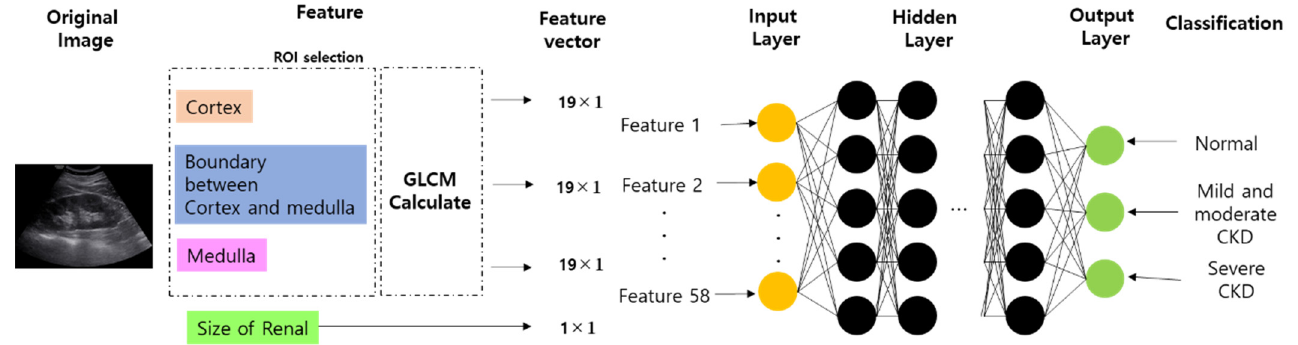
Figure 4. Output classification based on the ANN model. Table 3. Parameters of the